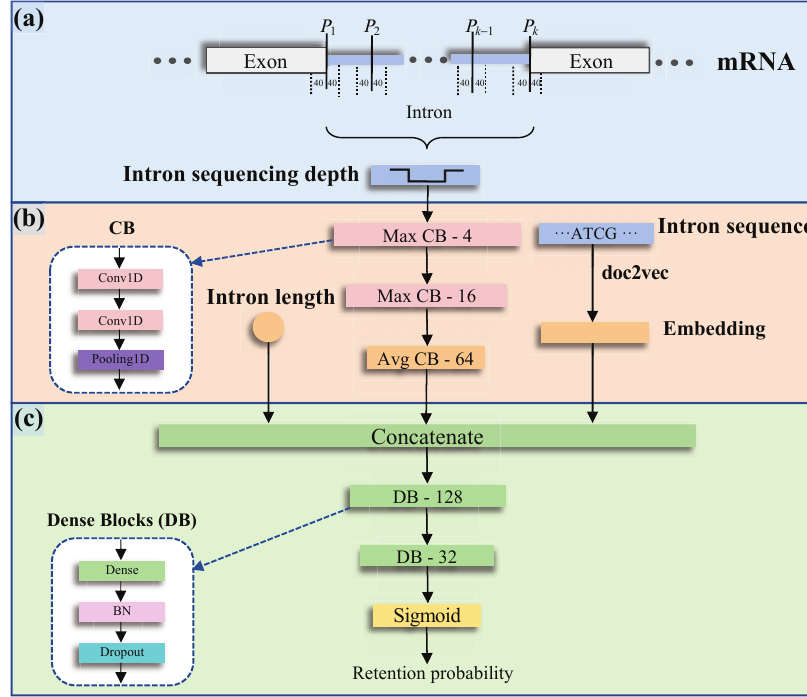
Fig. 1 Workflow of DeepRetention. (a) Calculation of raw sequencing depth of introns to obtain the distribution pattern. (b) Extraction of the distribution pattern of intron sequencing depth, intron sequence, and intron length features. (c) DeepRetention integrates the above features, and outputs the probability of introns being